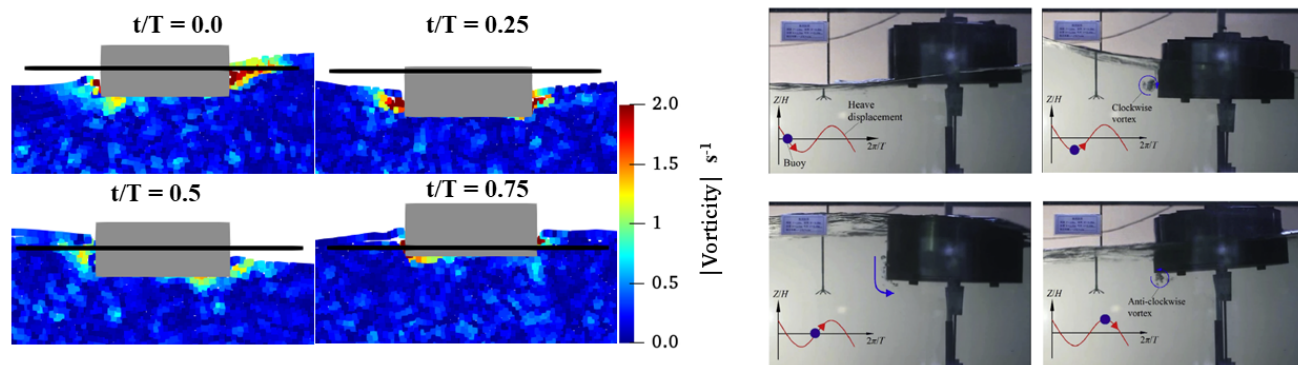
Figure 3. Vorticity in DualSPHysics surrounding a heaving cylindrical WEC in regular waves with H = 0.16 m, T = 1.5 s, B PTO , l = 1100 Ns/m ( left ), compared to experimental measurements of the heaving WEC, as performed in [56] ( right